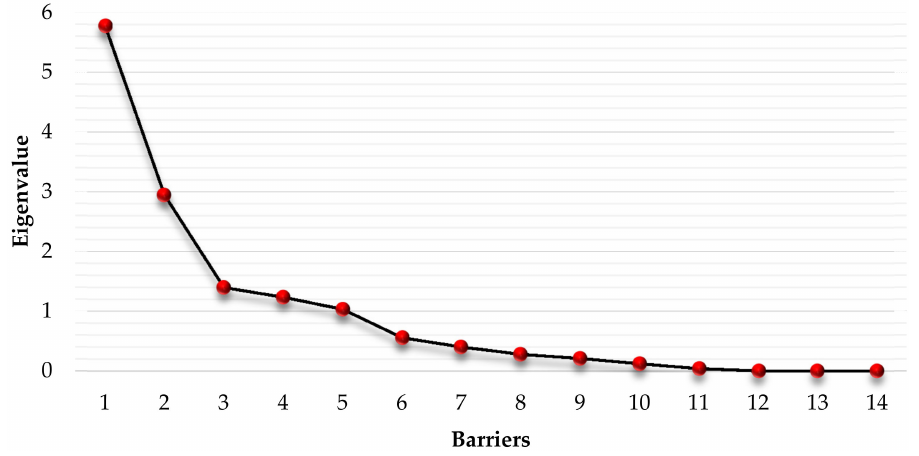
Figure 1. Scree plot. Table 4. EFA of the barriers to the use of digital technologies for VM practices.